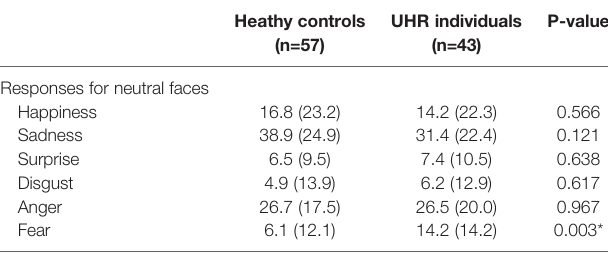
Heathy controls UHR individuals P-value (n=57) (n=43)